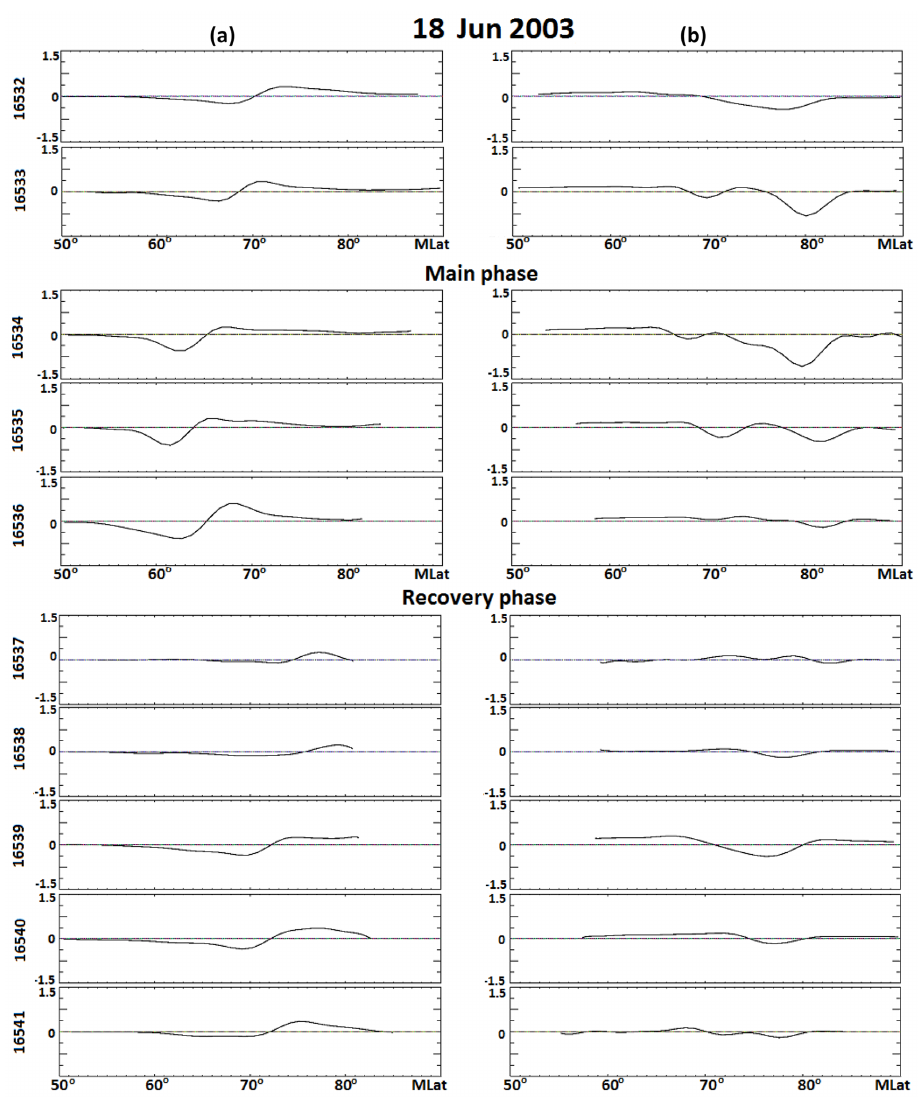
Figure A4. Direction and intensity values of the Hall current along the satellite orbit at the dayside ( a , 12:00–16:00MLT, corresponding to the ascending section of the orbit) and nightside sectors ( b , 00:00–04:00MLT, descending orbit section). Positive currents denote an eastward current for the descending orbit section and a westward current for the ascending section,